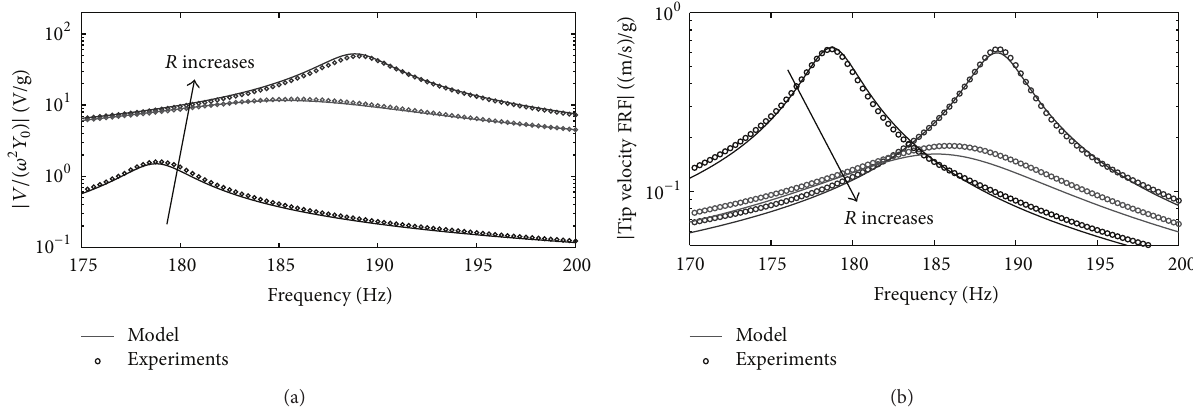
Figure 4: Model and experimental voltage FRFs (a) and tip velocity FRFs (b) for three values of load